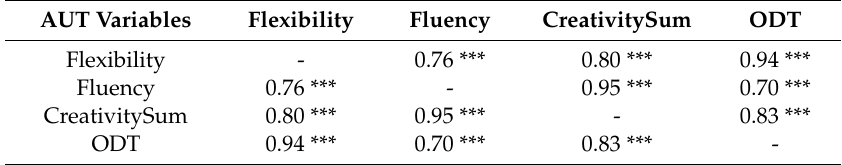
Table 1. Correlations between the three divergent thinking indices and overall divergent thinking. AUT Variables Flexibility Fluency CreativitySum ODT Flexibility - 0.76 *** Fluency 0.76 *** CreativitySum 0.80 *** Note. (***) p = <